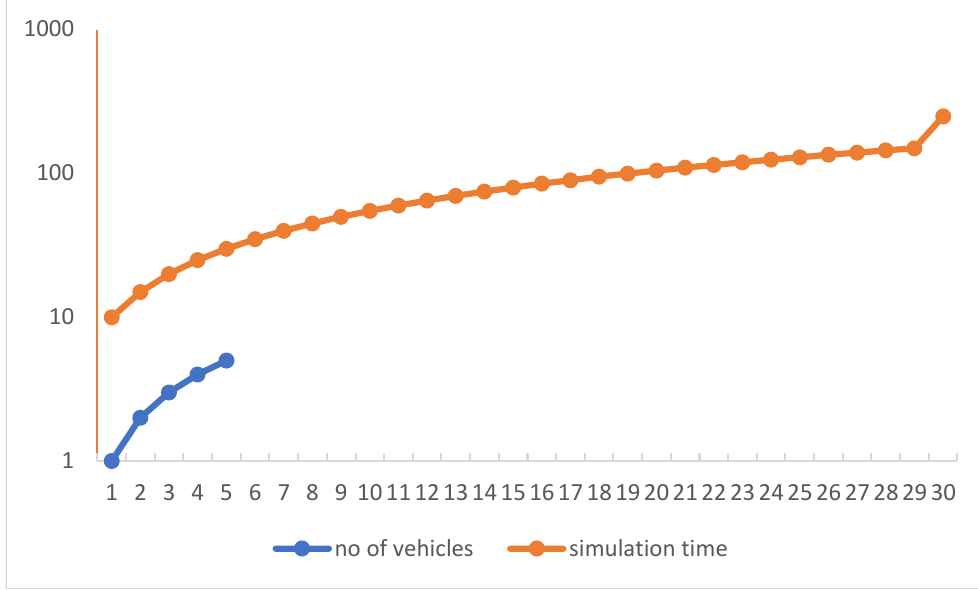
Figure 11. Number of beacons sent vs. simulation time.